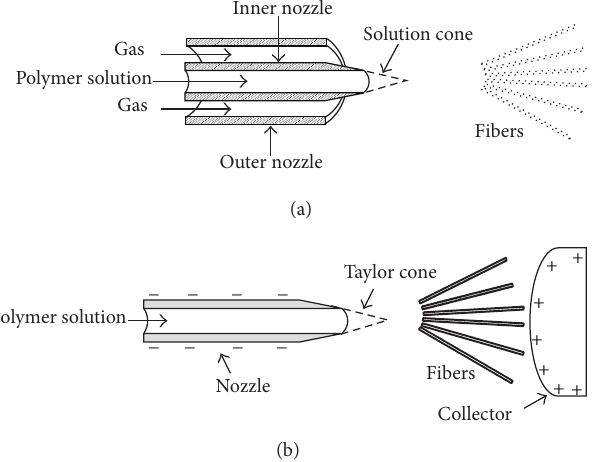
Scheme1:Cutawaydiagramofthe(a)concentricnozzlesystemused in solution blow spinning and (b) electrospinning processes.